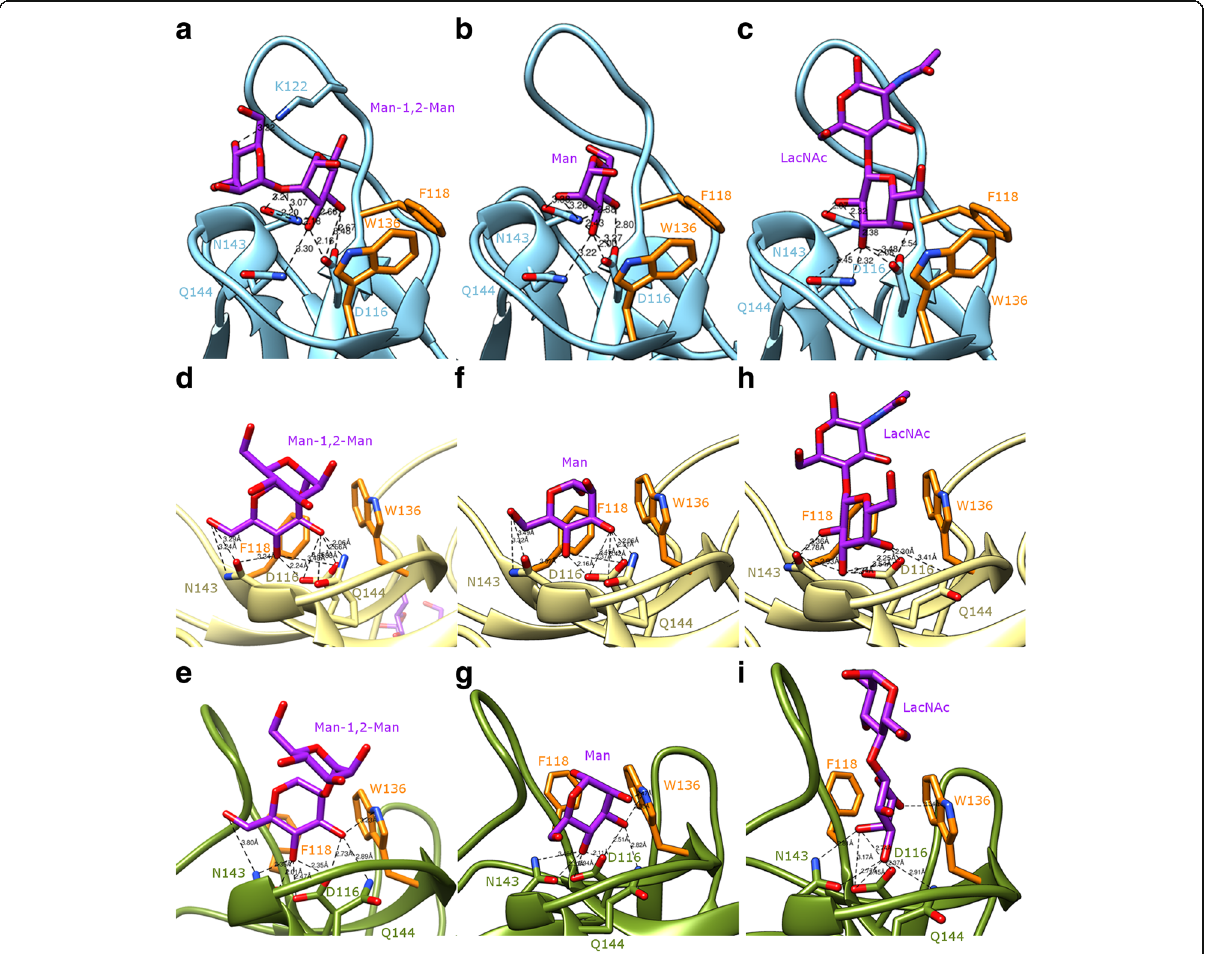
Fig. 4 Binding models of selected ligands in the carbohydrate-binding site of OsEULS2 and OsEULD1A. A-C. Side-view of the carbohydrate- binding site of OsEULS2 showing the docking of Man1,2Man ( a ), Man ( b ) or LacNAc ( c ) to the carbohydrate-binding site. d - i . Side-view of the carbohydrate-binding site of OsEULD1A showing the docking of Man1,2Man ( d - e ), Man ( f - g ) or LacNAc ( h - i ) to the carbohydrate-binding site of the first ( d , f and h ) or second ( e , g and i ) EUL domain. The H-bond distances are indicated (Å). A stacking interaction occurs between the first Man ring ( a , d and e ), Man ( b , f and g ) or Gal ( c , h and i ) and the aromatic residues F118 and W136 (colored orange) located in the vicinity of the active